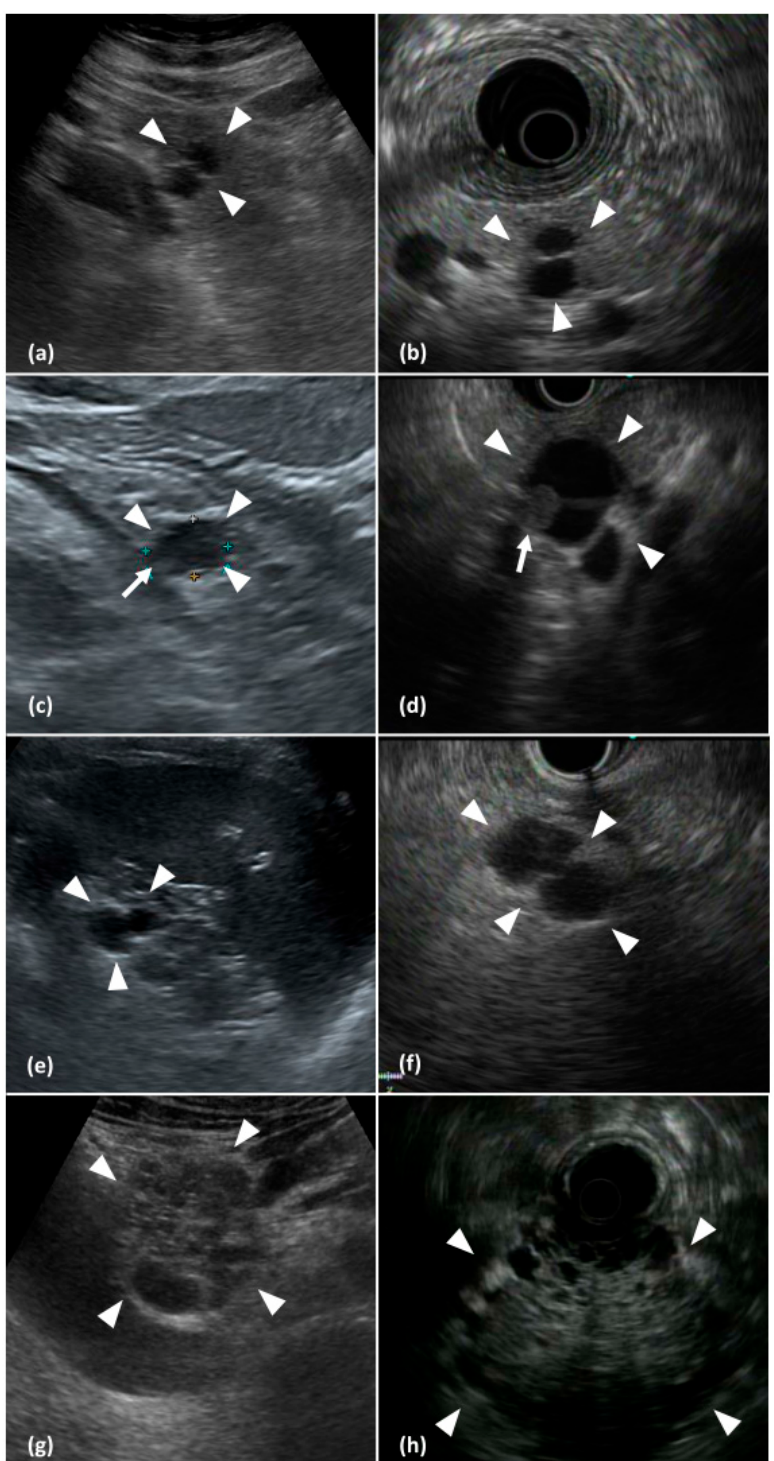
Figure 1. Pancreatic cystic lesions detected on abdominal ultrasonography (US; left column images) and corresponding endoscopic ultrasonography (EUS; right column images). ( a , b ) A bilocular cystic lesion (arrowheads) with a thin internal septum in the body of the pancreas. ( c , d ) An oligolocular cystic lesion (arrowheads) with a solid component (arrows) in the tail of the pancreas. ( e ) An oligolocular cystic lesion (arrowheads) detected on a transsplenic scan of the pancreatic tail and the corresponding EUS image ( f ). ( g , h ) A large microcystic lesion (arrowheads) with a honeycomb appearance in the head of the pancreas.